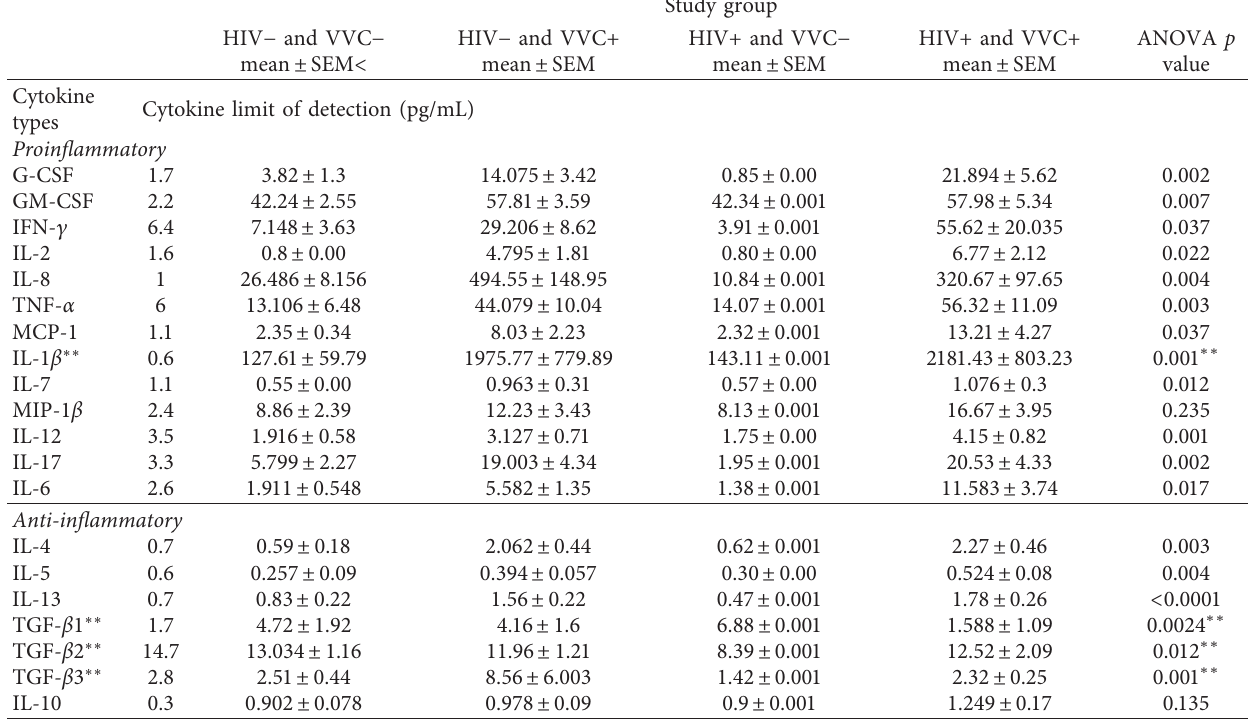
Table 5: Comparisons of cervicovaginal secretions’ mean levels (in pg/ml) of cytokine distribution across the study